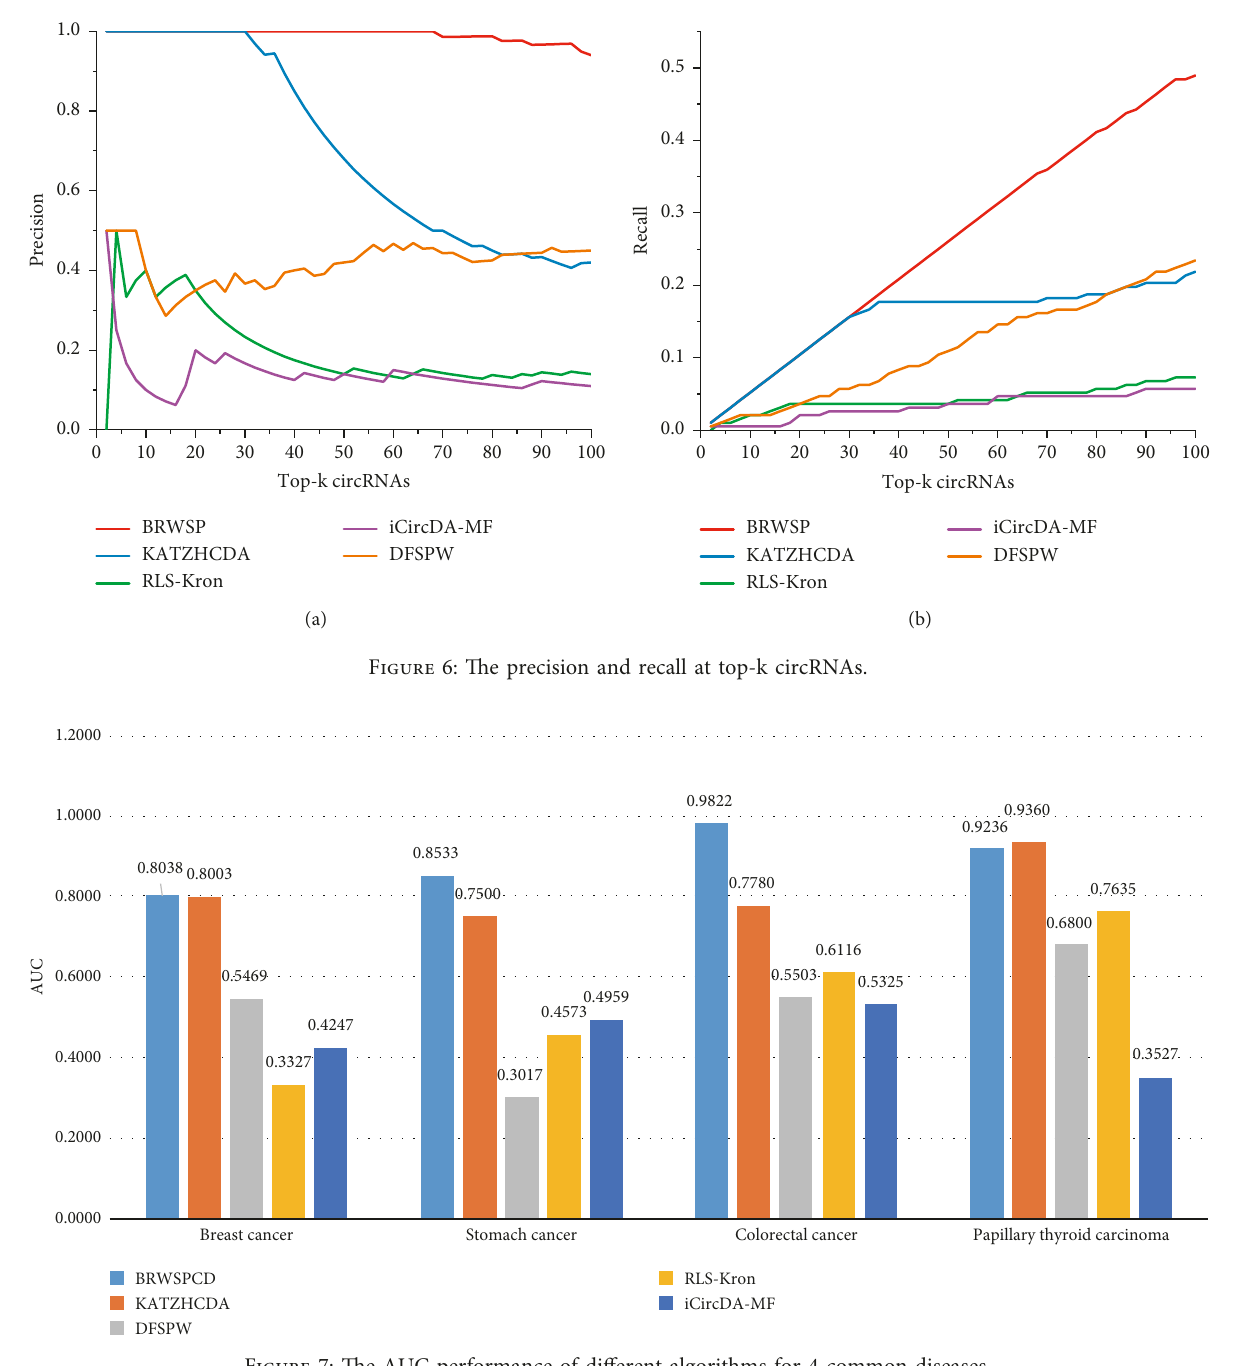
Figure 7: The AUC performance of different algorithms for 4 common